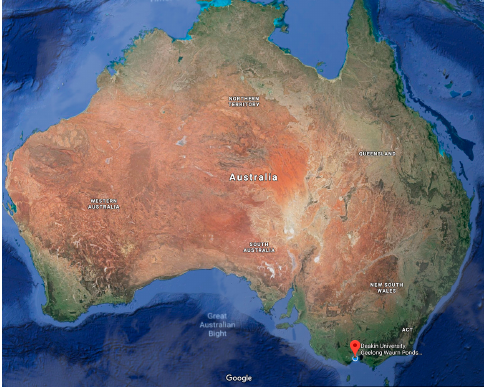
Figure 10. Geographical location of the test location [46]. Energies 2017 , 10 , x